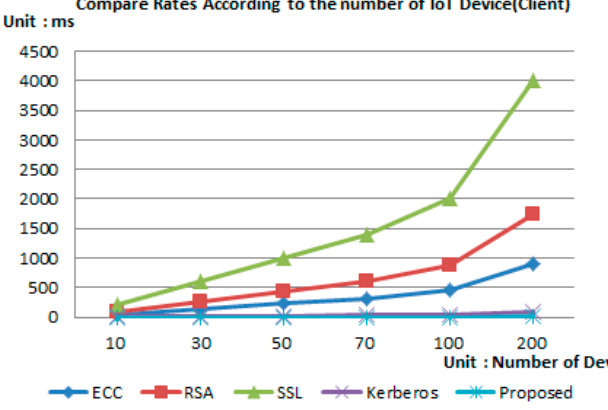
Figure 7. Analysis of authentication time—client.